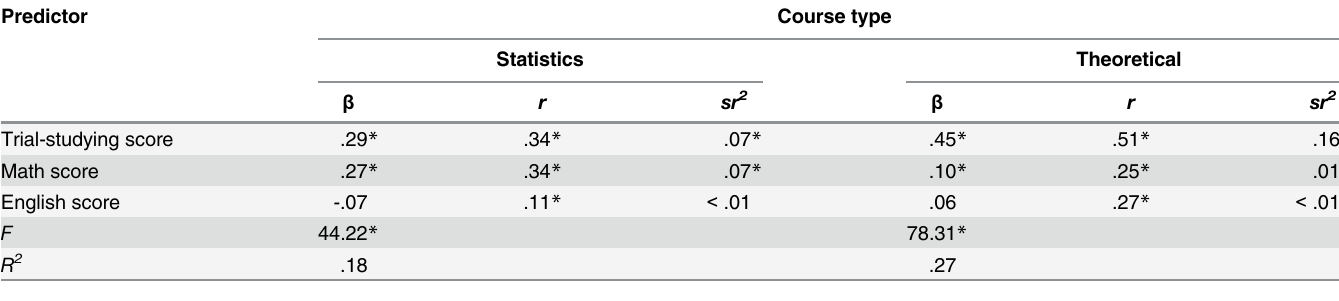
Table 3. Multiple Regression Results Predicting Specific Course Achievement with the Selection Test Scores.